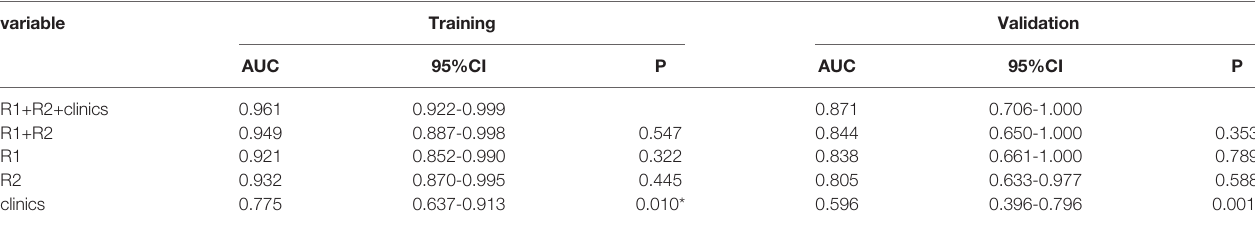
TABLE 7 | The AUC of radiomics model and clinics